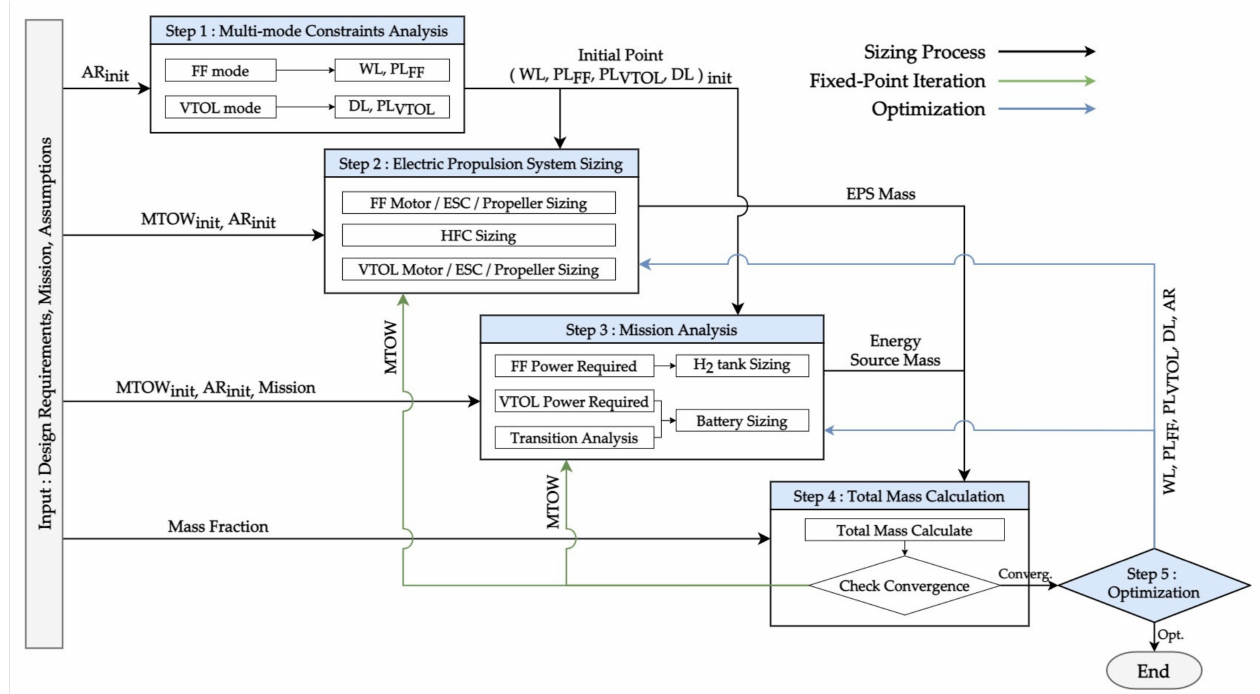
Figure 3. Sizing